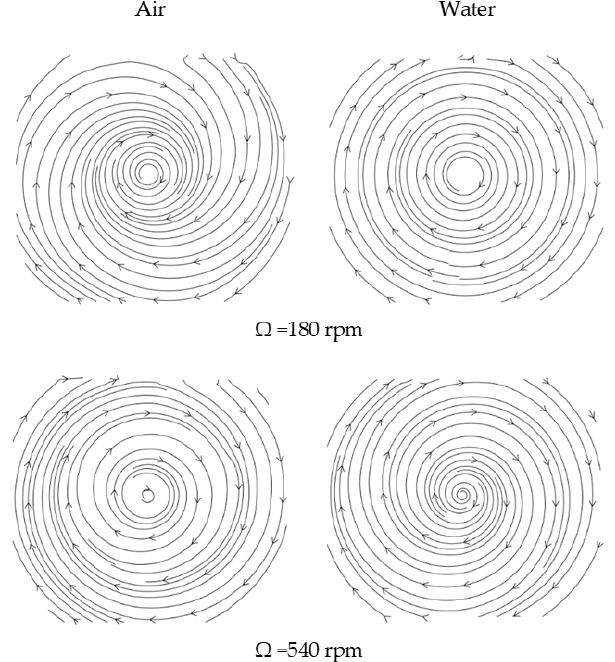
Figure 5. The streamlines reconstructed from the vector fields obtained in a horizontal section near the interface (( left )—in air; ( right )—in the working model fluid).